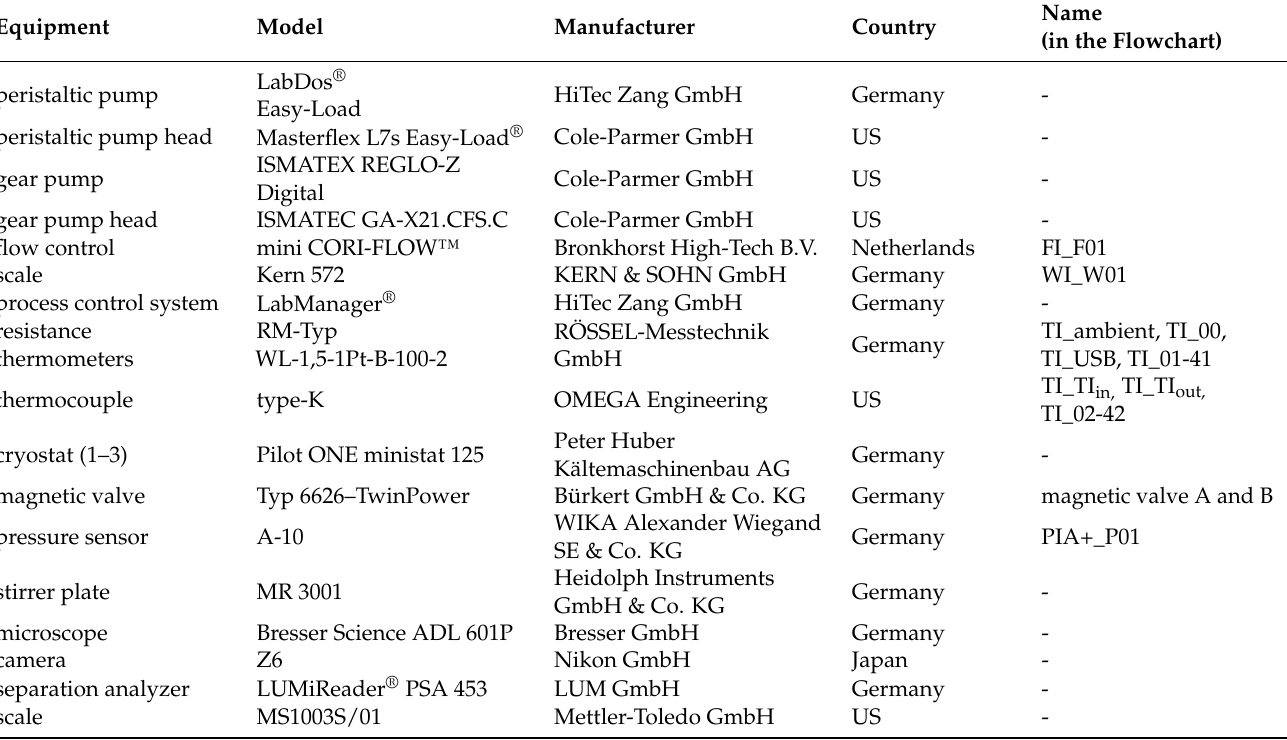
Table A2. Equipment list for the experimental